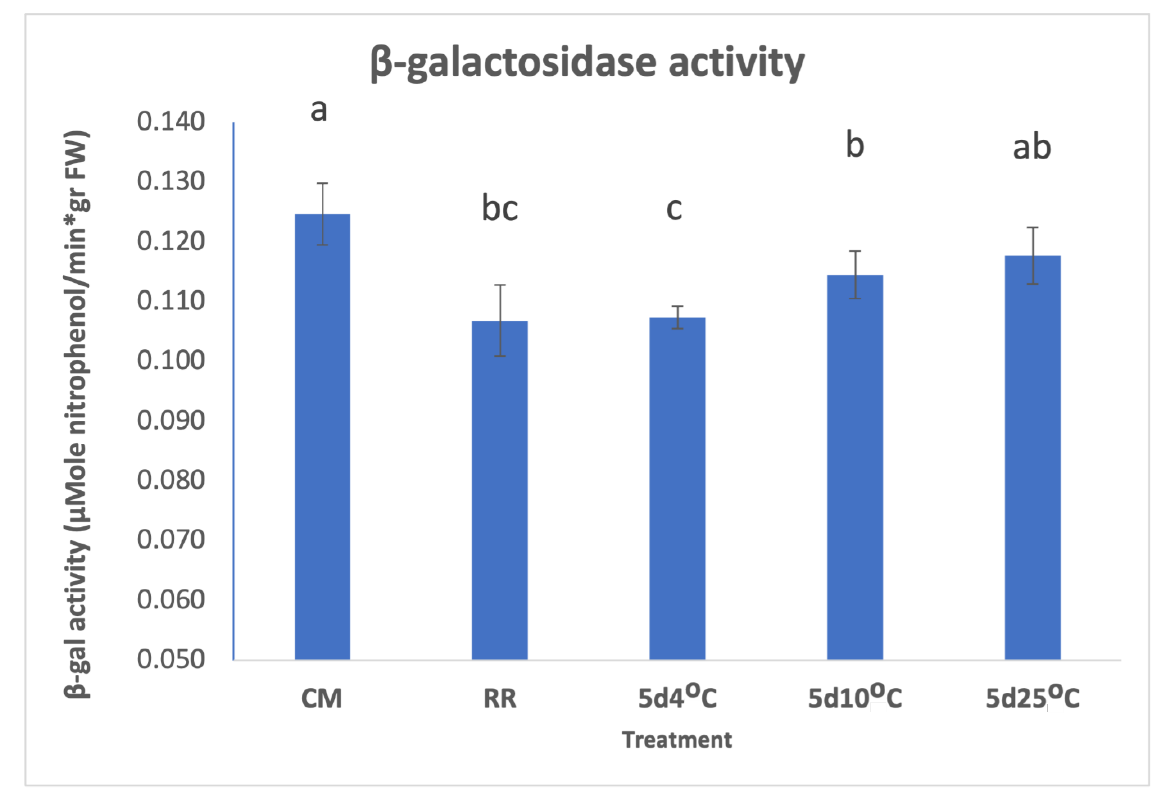
Figure 4. β -GAL enzyme activity in tomato fruit cv. Chondrokatsari during late maturation and after postharvest storage (5 d) at different temperatures (4, 10 and 25 °C). Significant differences between treatments were determined by one-way ANOVA and false discovery rate (FDR) correc- tion. Bars represent means (±SE) of three biological replications.